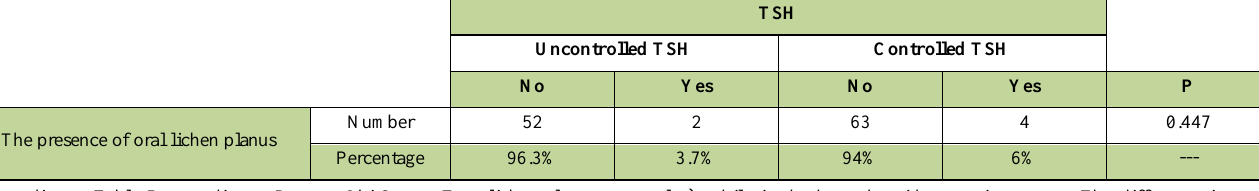
Table 4. Comparison of oral lesions in two groups of hypothyroid patients with controlled and uncontrolled TSH.